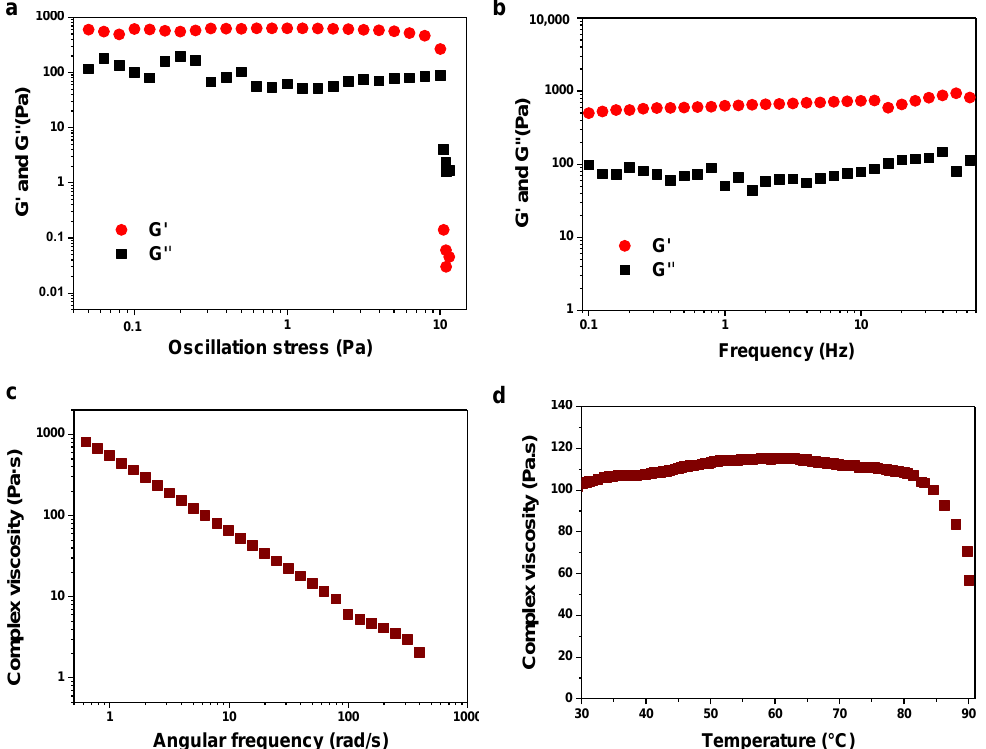
Figure 2. Rheological measurements for the hydrogel formed from 6b (1 mg/mL, H 2 O:DMSO (90:10 v / v )). ( a ) Amplitude sweeps with 1 Hz at 25 °C; ( b ) frequency sweeps with 0.1 Pa strain at 25 °C; ( c ) complex viscosity vs. angular frequency; and ( d ) the dependence of the complex viscosity on the temperature using a heating rate of 0.2 °C/min and a constant frequency of 1 Hz and 0.1% strain. Table 2. Gelation properties as a function of pH for 6b (1 mg/mL) in H 2 O:DMSO (90:10 v / v ). Vial Buffer (mM) pH Result 1